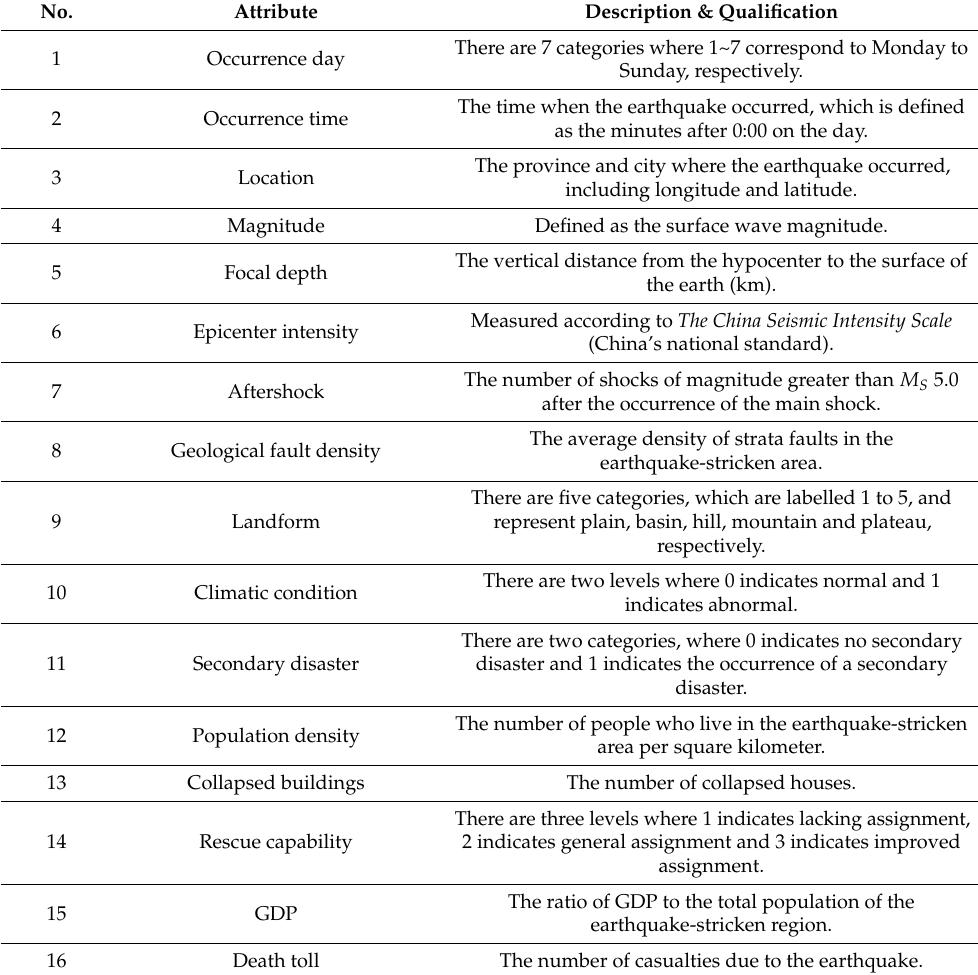
Table 1. Specification of attributes in the earthquake case